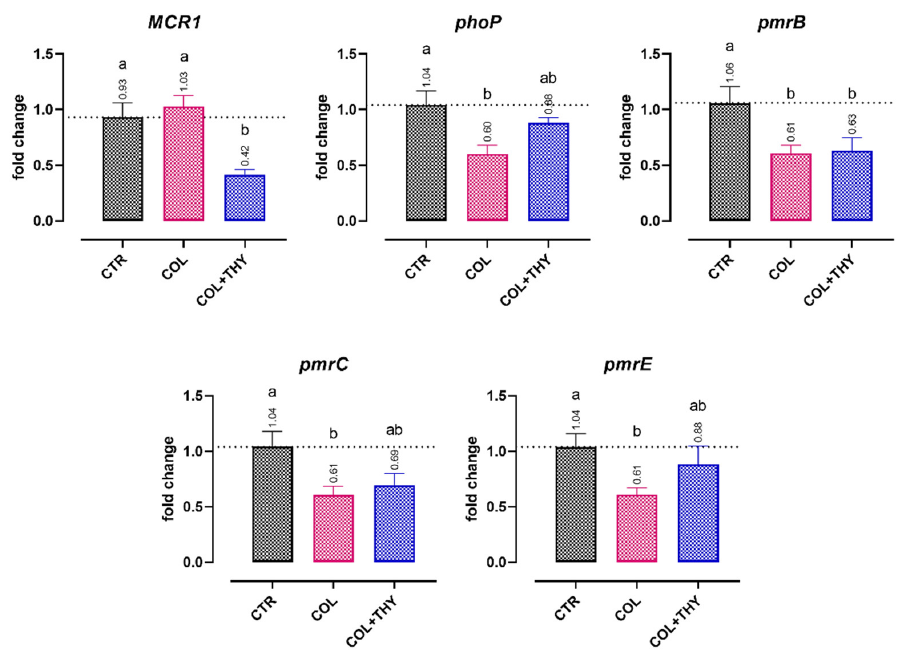
Figure 4. Effects of colistin (MIC/4, 8 mg/L, COL) or a combination of colistin and thymol (MIC/4, 0.47 mM, COL + THY) on ETEC 95′s and ETEC 97′s expression of antibiotic resistance genes related to enzymes that have a direct role in LPS modification ( MCR-1 , pmrC , and pmrE ), and regulator proteins that belong to two-component systems ( phoP and pmrB ). Data are expressed as the means of the three technical replicates of the two studied strains, with the SEM reported as vertical bars. For each gene, the data were analyzed by one-way ANOVA with Tukey’s multiple comparison test; superscript letters (a, b) indicate significant differences between groups ( p < 0.05).